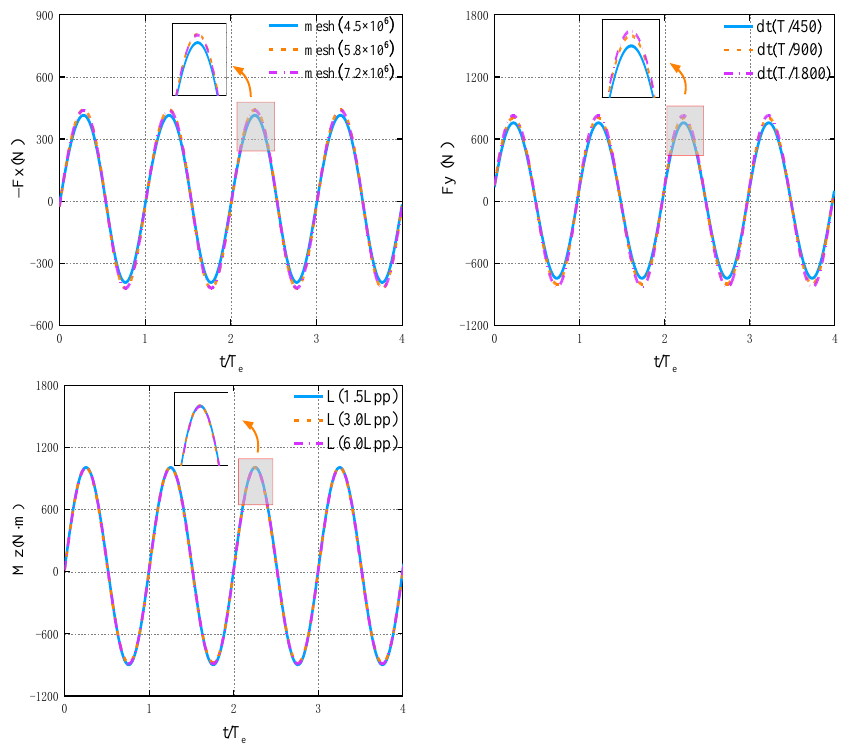
Figure 13. The convergence analysis surge, sway, and yaw forces and moment of the KVLCC2 ship under different mesh numbers, time-step scales, and damping zone length, respectively.